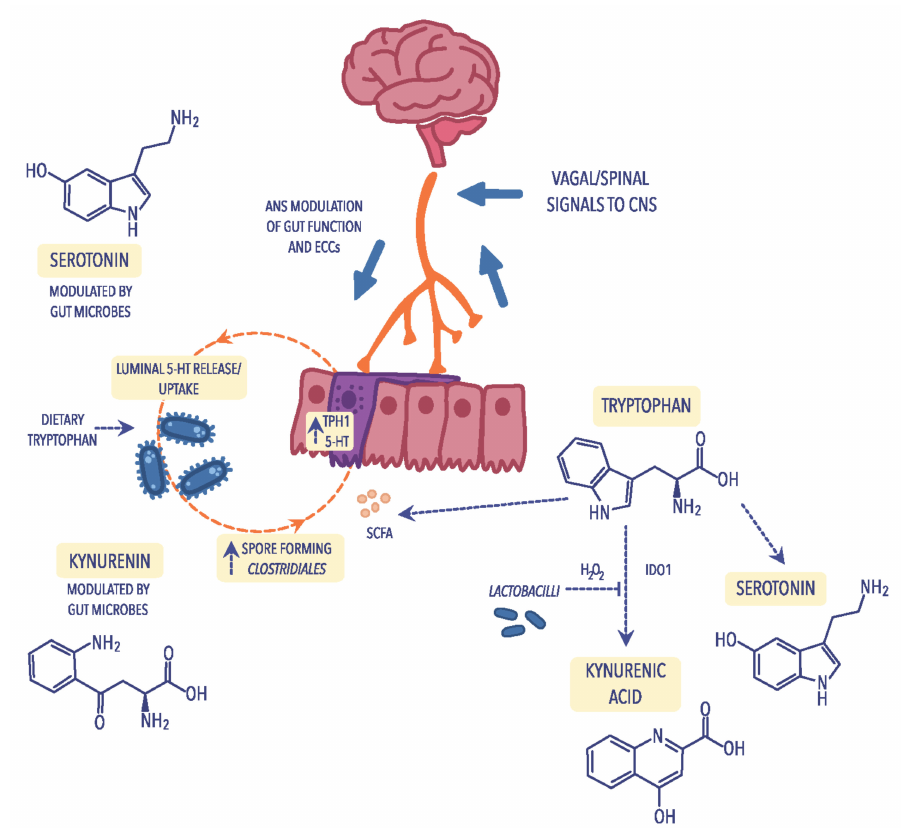
Figure 2. Metabolism of tryptophan through different pathways: the kynurenine pathway that leads to the production of kynurenine and its derivatives in reliance on indoleamine 2,3-dioxygenase (IDO); the serotonin pathway, including the enterochromaffin cells (ECCs) in which tryptophan is transformed into serotonin (5-HT) and its derivatives and is dependent on short-chain fatty acids (SCFAs) which are biosynthesized by spore-forming Clostridiales . ECCs can be activated by the autonomic nervous system (ANS) to secrete 5-HT into the gut lumen, where it can communicate with the intestinal microbiota. Figure was created using the Vectornator